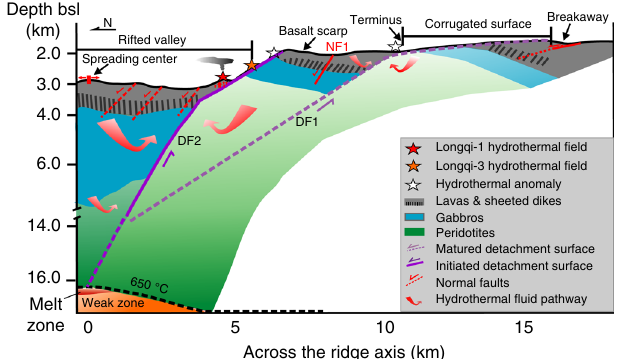
Fig. 4 Proposed geological model for hydrothermal circulation of the Dragon Horn area. The tectonic pattern follows the rolling-hinge models 23 . Hydrothermal circulation is driven by the twin detachment faults from the deep heat source at the depth of 13 ± 2 km